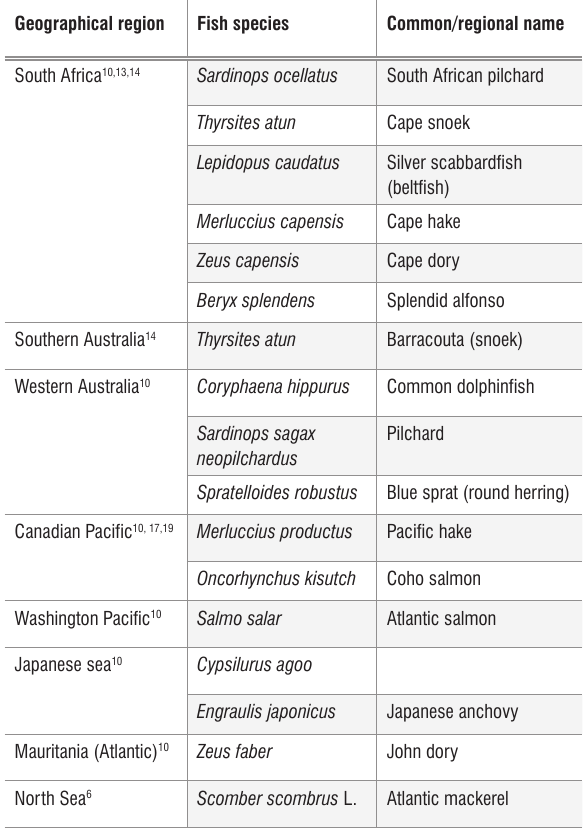
Geographical region